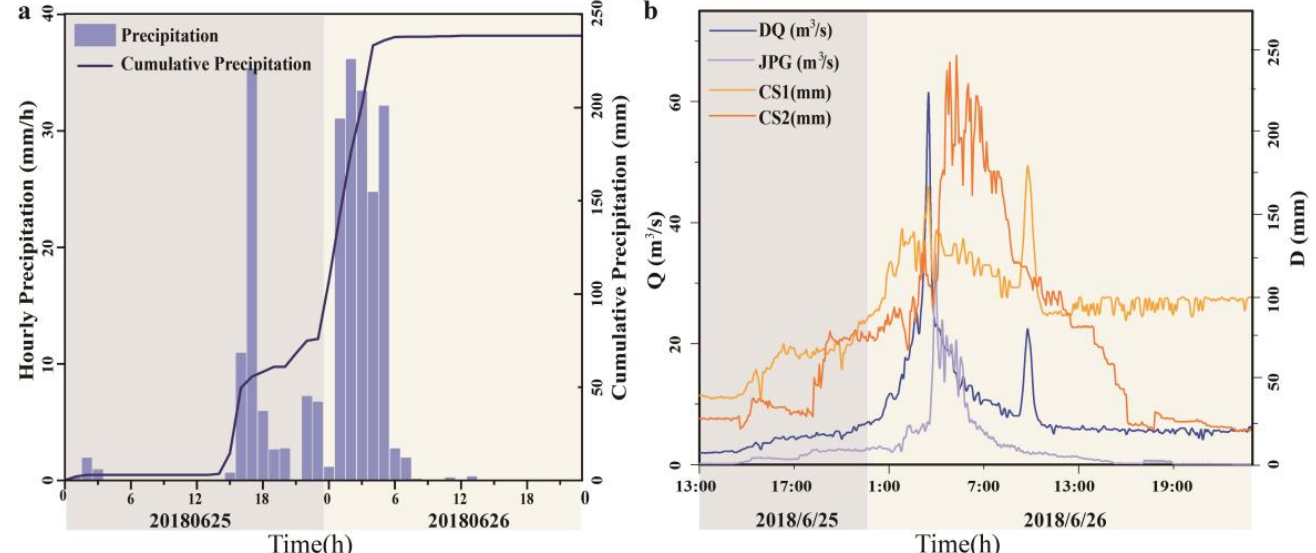
Figure 3. Characteristics of monitoring data in Longxi River: ( a ). Hourly precipitation from 25 June to 26 June 2018 ( b ). Hydrological and hydraulic parameters in the monitoring cross sections including the discharge and critical size of the movement.